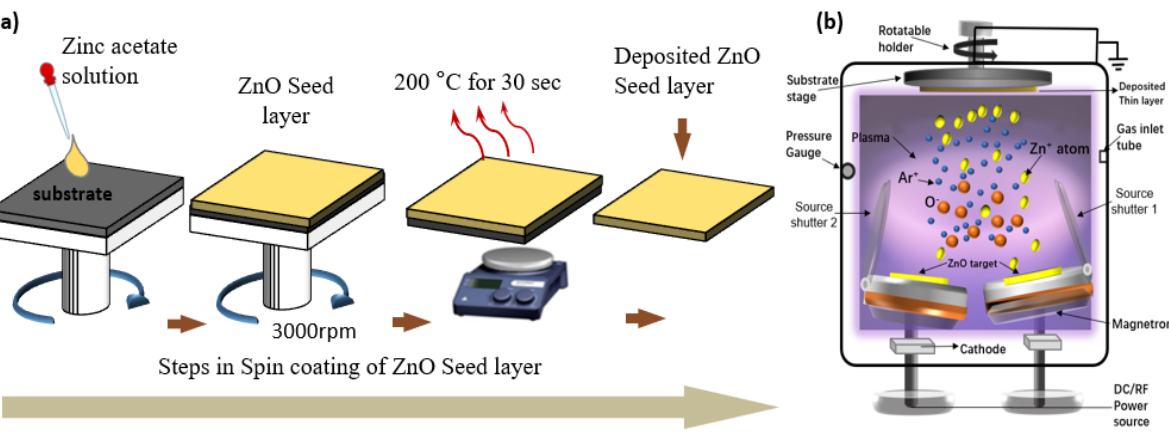
Figure 3. ( a ) Schematic illustration of the ZnO seed layer deposition by a spin coating method and ( b ) magnetron sputtering deposition.